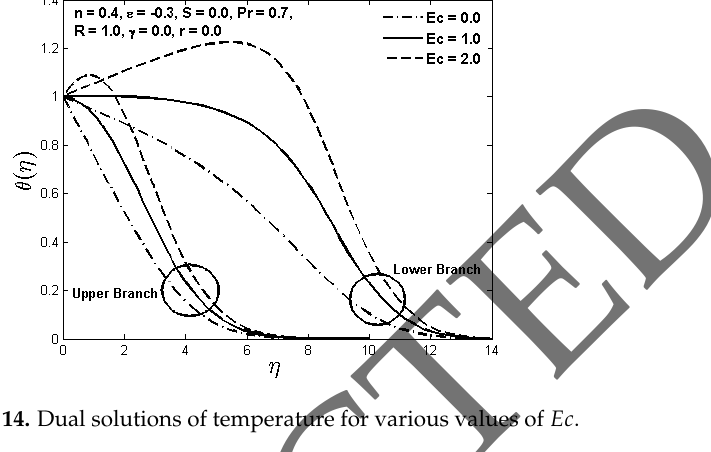
Figure 14. Dual solutions of temperature for various values of Ec .